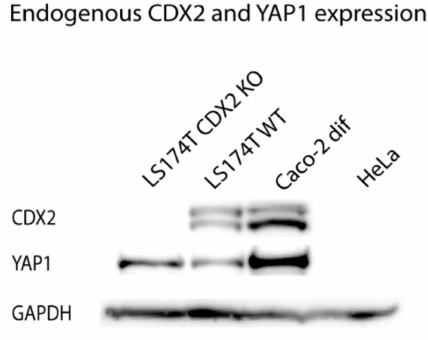
Comparison of CDX2 and YAP1 protein expression using Western blotting, using glyceraldehyde-3-phosphate dehydrogenase (GAPDH) as a reference. Cell lysates are from confluent cells from the intestinal cell lines Caco-2 and LS174T with and without CDX2 knockout (KO), as well as the non-intestinal cell line HeLa. All bands are from the same gel and images were globally adjusted for contrast and